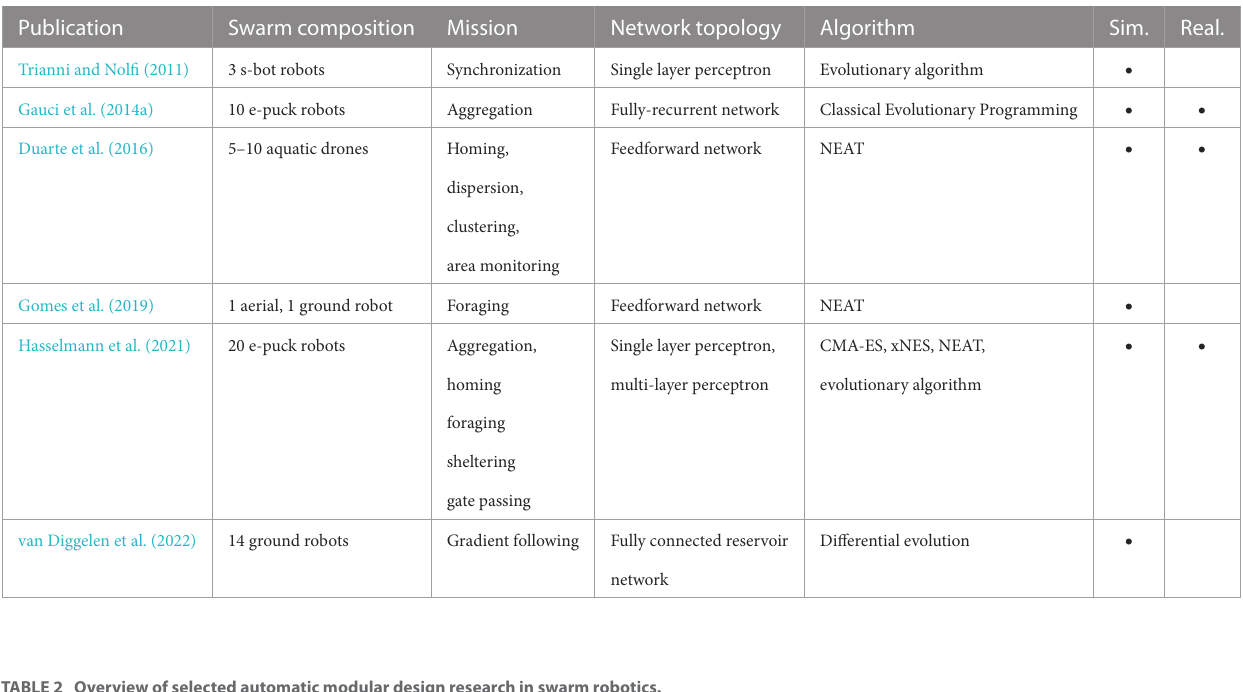
TABLE1 Overviewofselectedneuro-evolutionaryresearchinswarmrobotics.